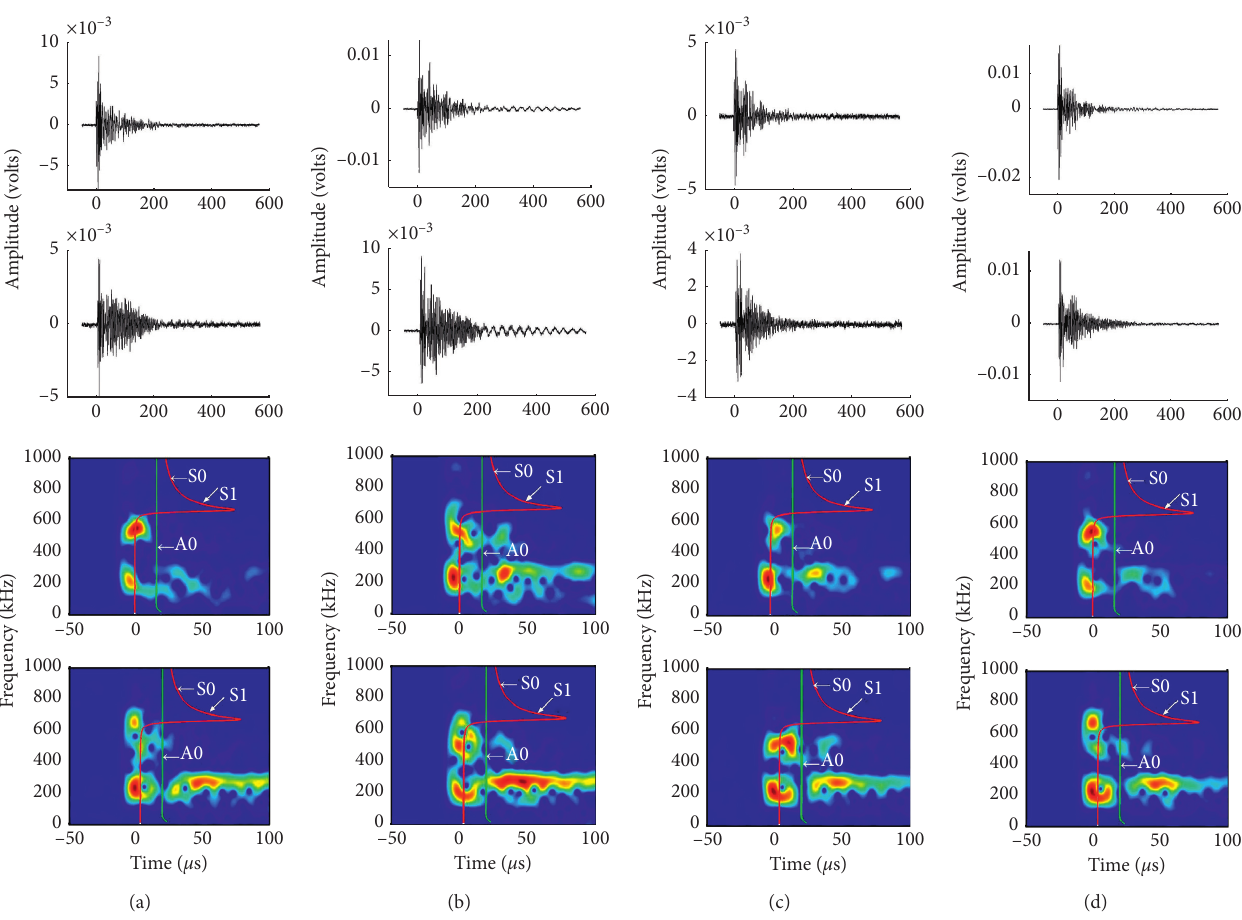
� 28.6s. (b) t � 56.7s. (c) t � 109s. (d) t � 8 ] s layup. (a) t